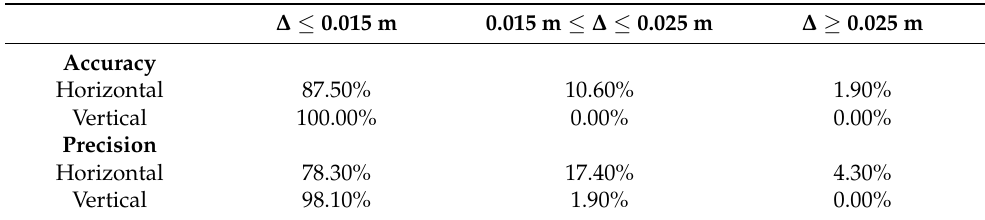
Table 1. Accuracy and precision analysis of the static, reference point cloud. Percentages indicate the proportion of coordinate differences lying within each indicated